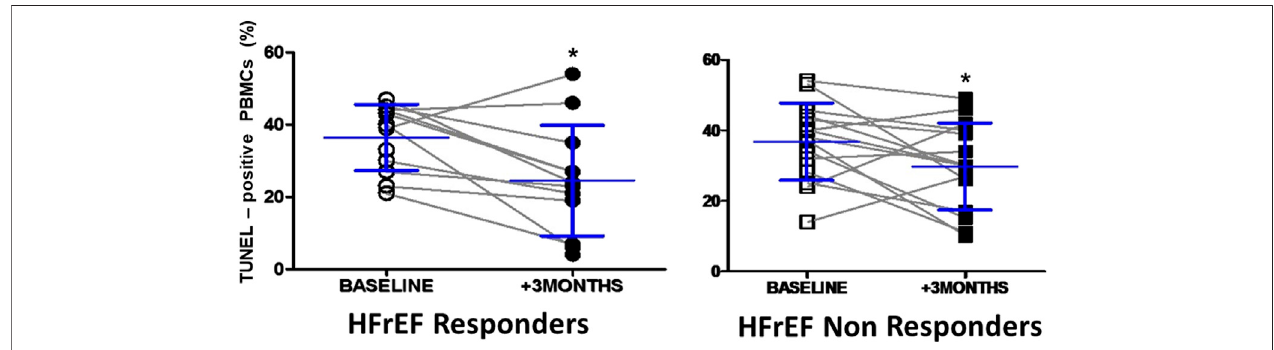
FIGURE 4 | Apoptosis levels in circulating leukocytes in responders and non responders HFrEF patients before and after cardiac resynchronization therapy. TUNEL-positive nuclei baseline and 3 months after cardiac resynchronization therapy in responders and non responders HFrEF patients. Data shown as mean ± SD. Symbols: * p (cid:1) < 0.05 vs.